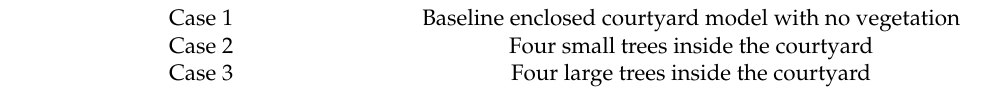
Figure 1. The courtyard model with natural ventilation and vegetation. Table 1. Three scenarios for the modelling of the ventilation and thermal performance of the courtyard building.